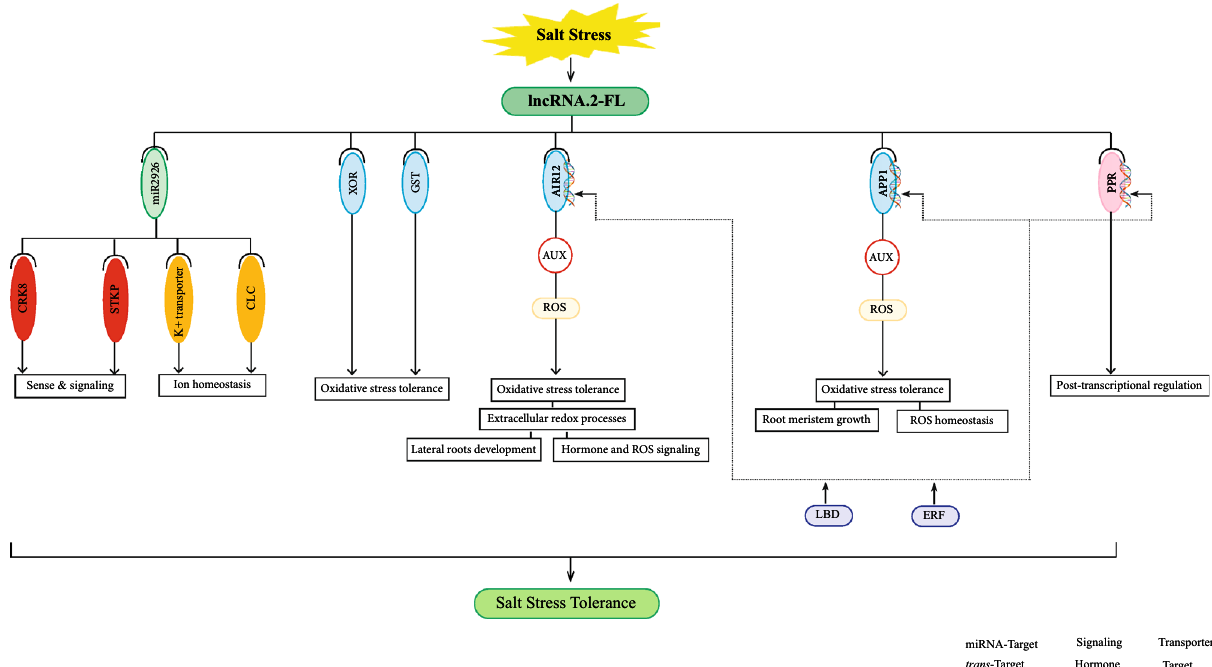
Figure 8. The hypothetical model for regulatory network through lncRNA.2-FL in FL478 under salt